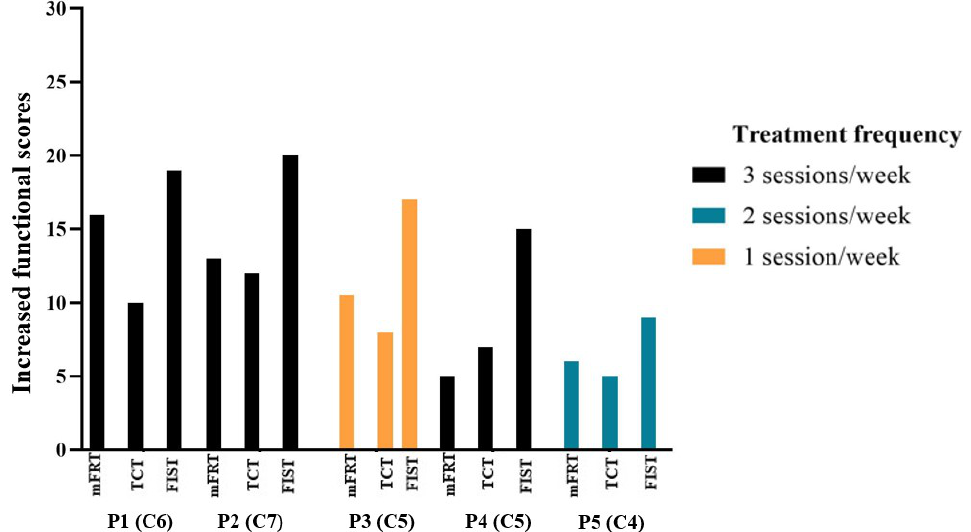
Figure 9. The increased functional scores based on treatment frequency obtained by the participants (cervical cord injury level: C4, C5, C6, C7) during the functional assessment of Modified Functional Reach Test (mFRT), Trunk Control Test (TCT), and Function in Sitting Test (FIST). A higher score indicates an improvement in function.